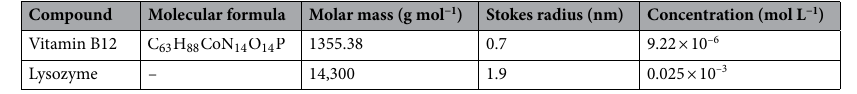
Table 1. Basic information on the compounds used in the filtration